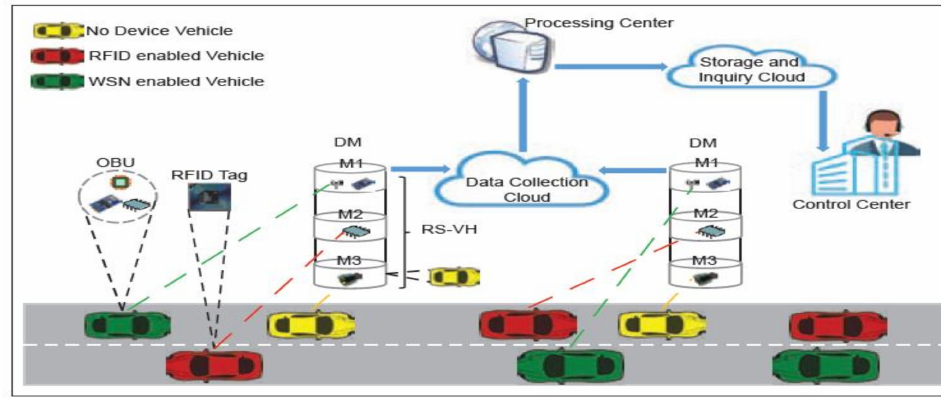
Figure 4. Architecture of IVS framework [18].